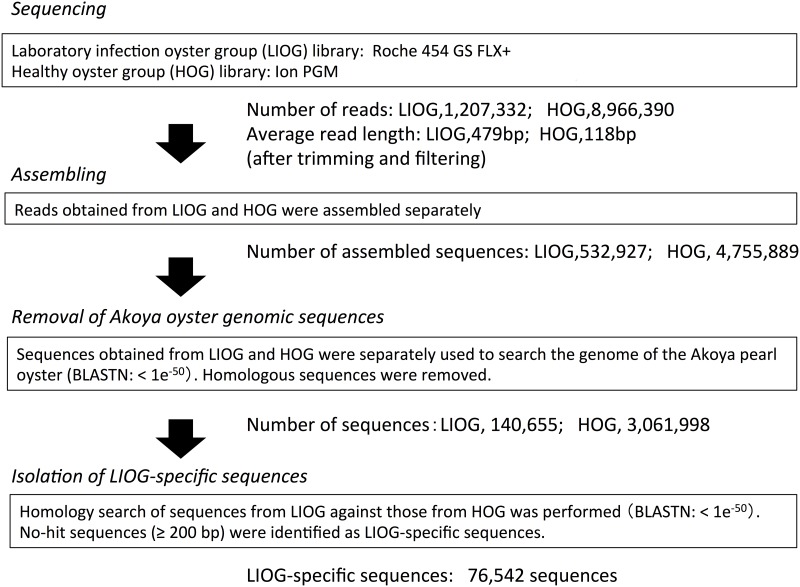
Strategy for analysis of shotgun metagenomic data.